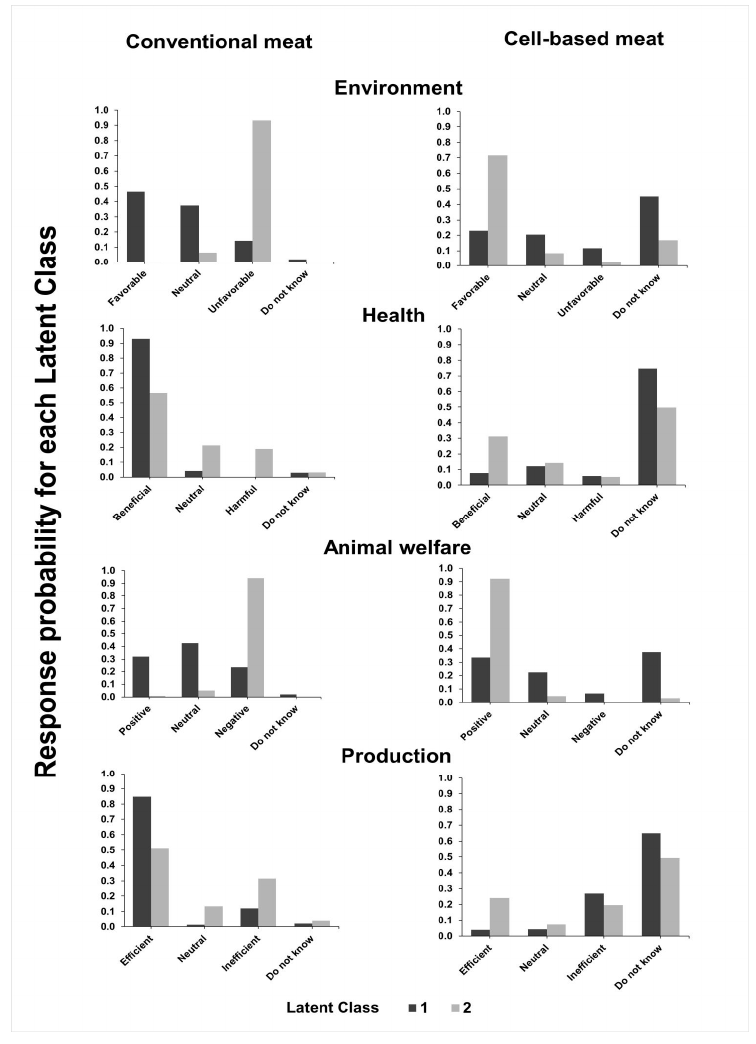
Figure 3. Perceptions of issues related to the environment, health, animal welfare and e ffi ciency of production of conventional and cell-based meat in each latent class (LC) by 209 Brazilian veterinarians and 63 animal scientists according to an online questionnaire. LC 1 (151 respondents) presents a more proconventional perception and LC 2 (121 respondents) a more pro-cell-based perception. Table 2. Results of the logistic regression model on the chances produced by latent class (LC) analysis for the group of questions related to the environment, health, animal welfare and e ffi ciency of production of conventional and cell-based meat, according to the responses to an online questionnaire by 209 Brazilian veterinarians and 63 animal scientists; Latent Class 2 presents a more pro-cell-based